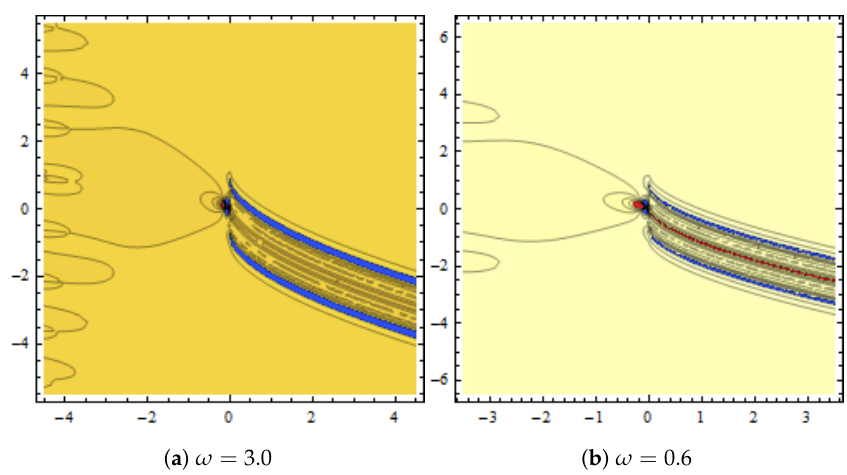
Figure 6. ( a , b ) show contour plots. The graphical behaviour of u ( x , t ) in Equation (26) is pre- sented with β 1 = 0.3, β 2 = 0.2, β 3 = 0.5, β 4 = 0.4, ζ = 0, l 1 = 0.3, l 2 = 0.1, l 4 = 4.5, l 5 = − 0.5, Q = 1.2, r 1 = 2.5, r 2 = 3.2, w 2 = 0.2, w 3 = 3.1, w 4 = 1.5, w 5 = 5 and φ = 1.4.